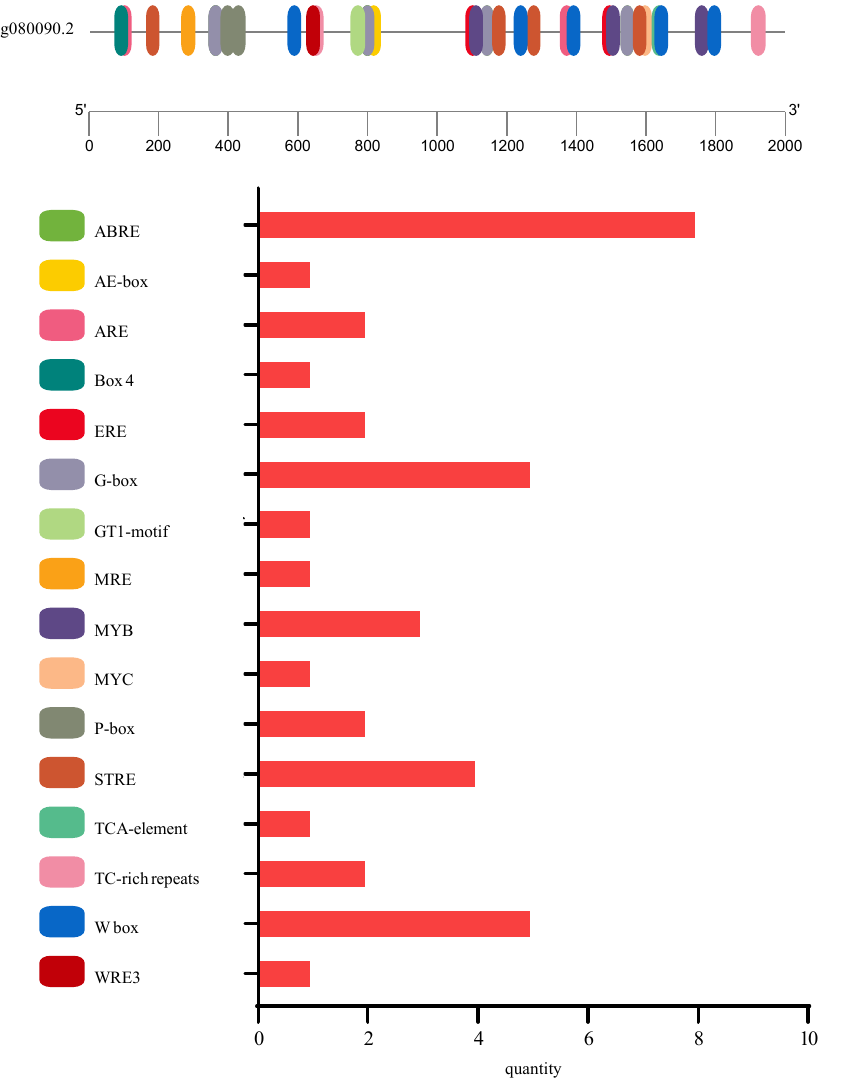
Figure 6. Visualization of cis-acting elements in the promoter sequence of SlSGR2.